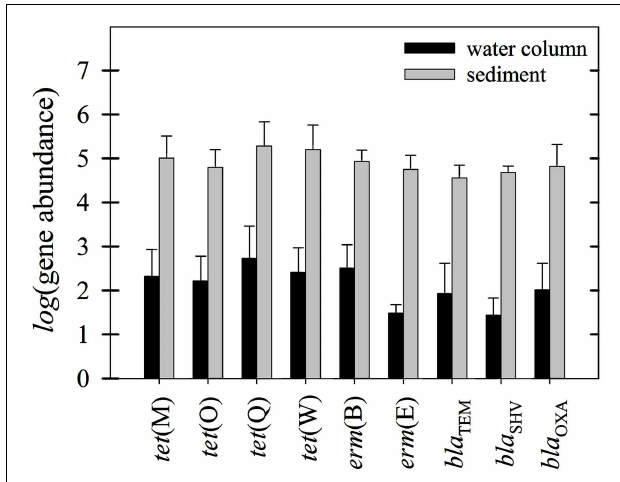
FIGURE 2 | Grand mean of all genes (absolute values; as per mL or per g-sediment) measured in theAlmendares River in both seasons. Ninety five percentage confidence intervals are denoted in parentheses.